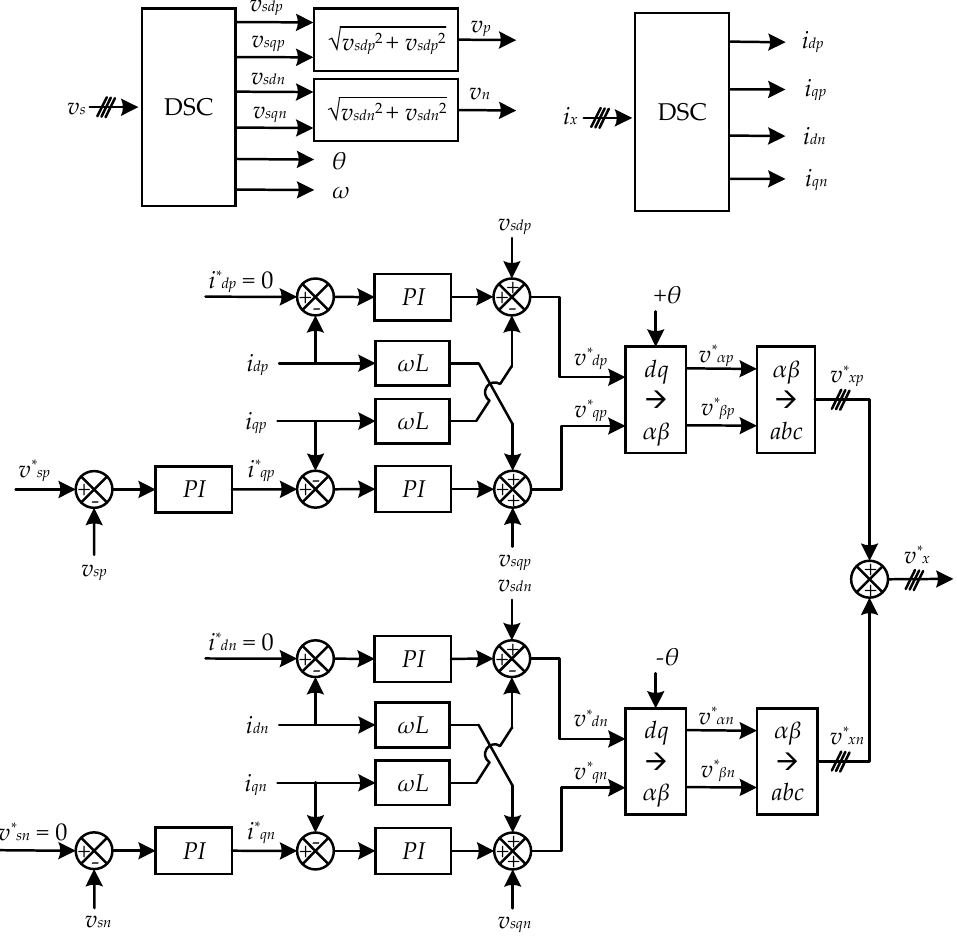
Figure 9. Output voltage and current control under unbalanced grid condition.